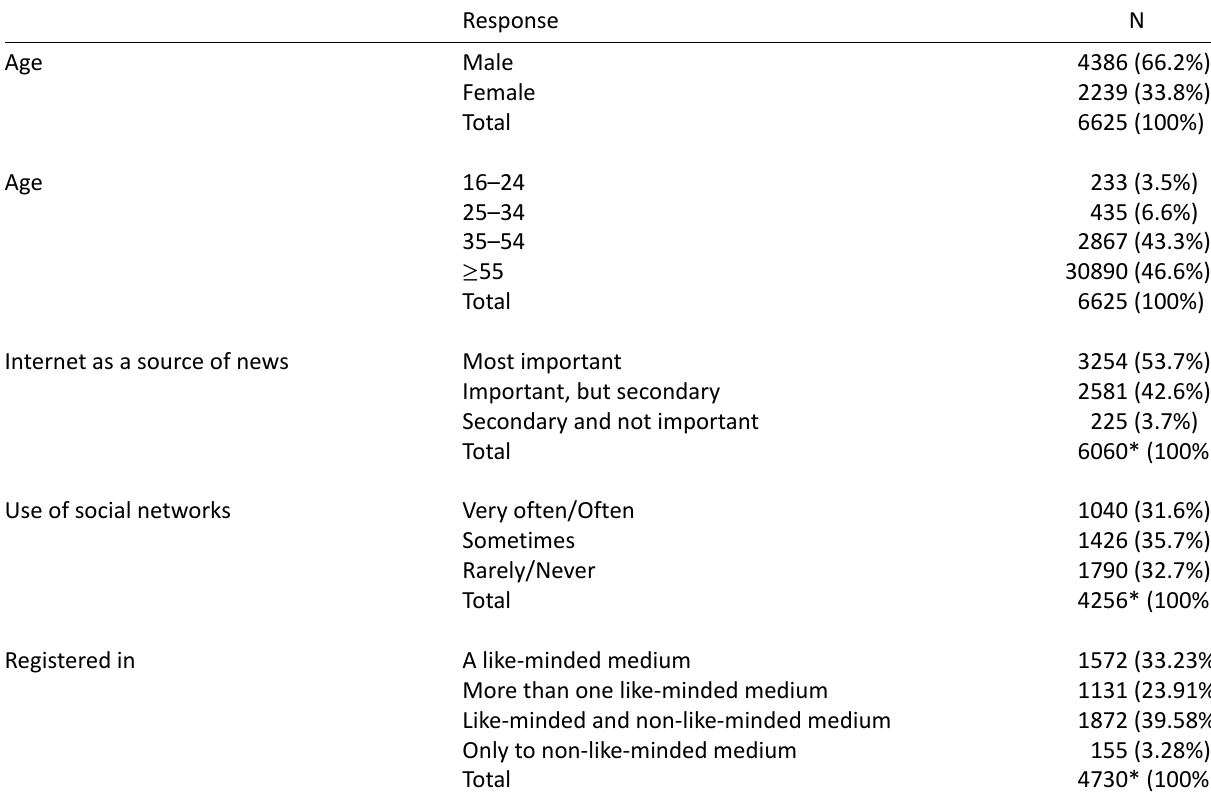
Table 1. Demographics and Internet and media